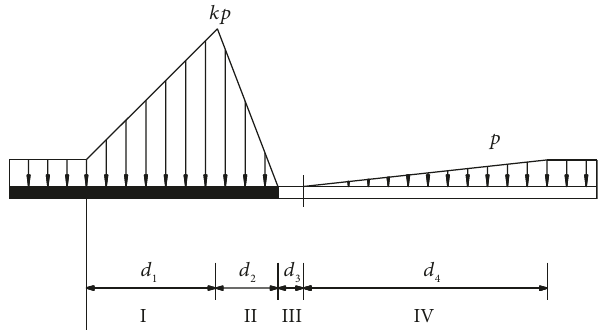
Figure 3: Distribution characteristics of mining abutment pressure after